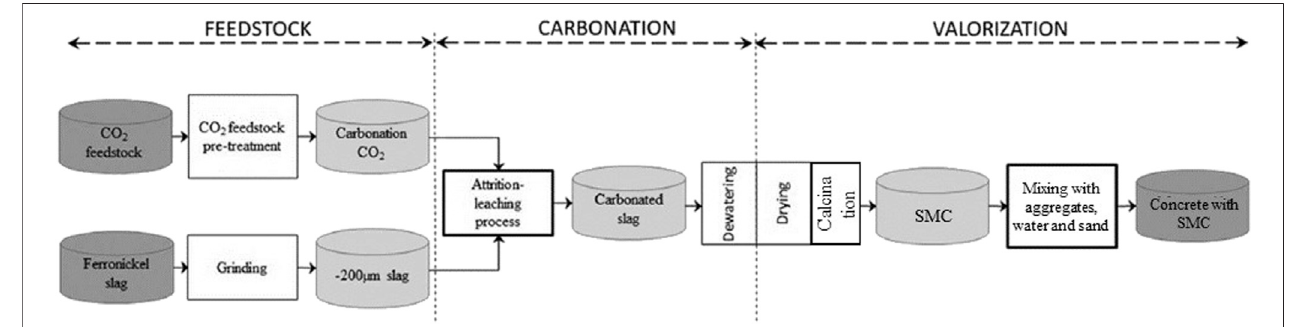
FIGURE 1 | Integrated CO 2 mineralization process for the production of SMC (silico-magnesian cement) from ferronickel slag — adapted from (Bourgeois et al., 2020).